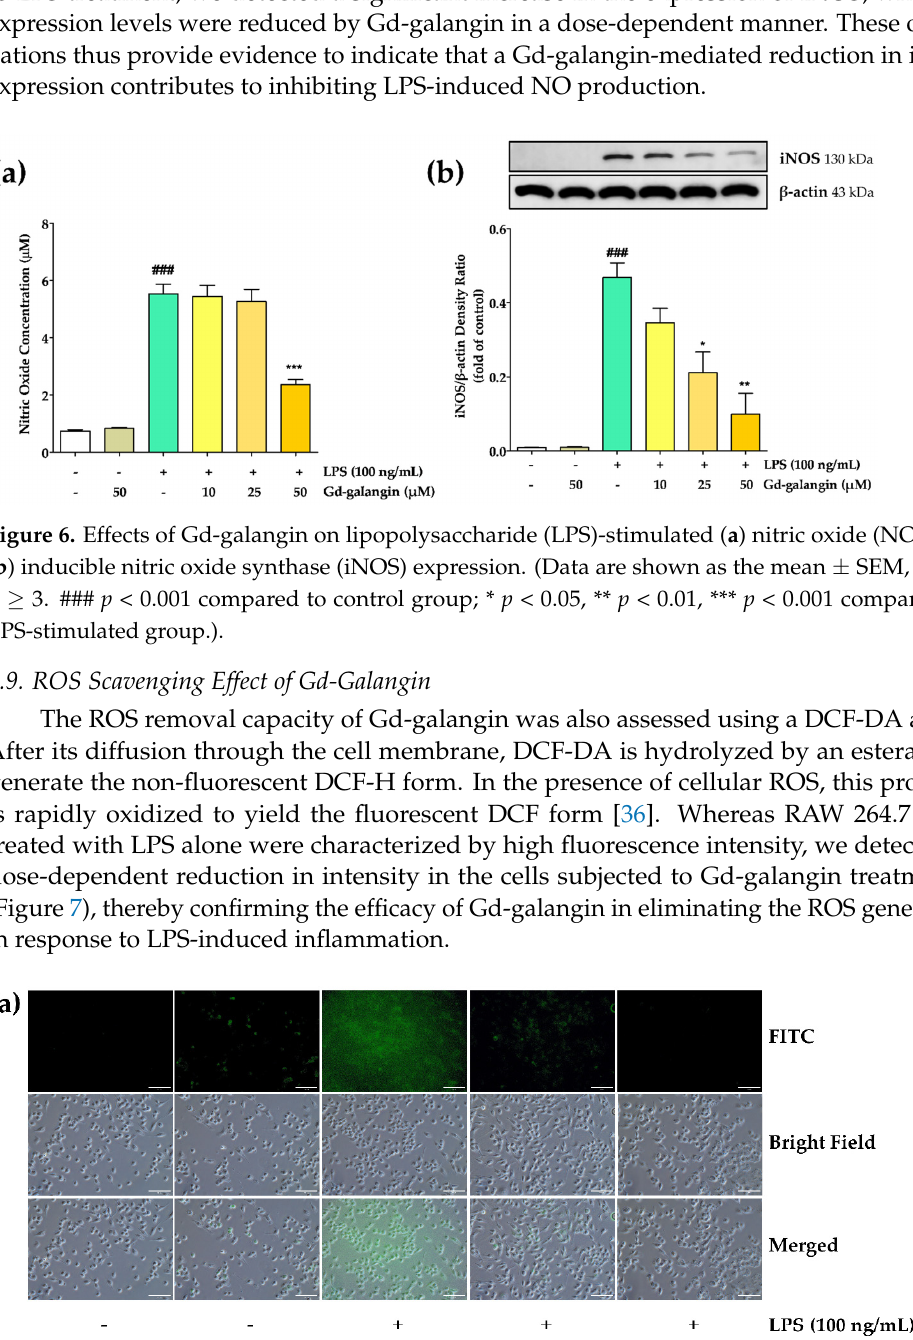
Figure 7. Reactive oxygen species (ROS)-scavenging effect of Gd-galangin on RAW 264.7 macro- phage cells. Cellular ROS was determined by 2,7-dichlorofluoroscin diacetate (DCFDA) assay. ( a ) Images of RAW 264.7 cells captured with fluorescence microscope. Scale bar, 100 μ m. ( b ) The fluo- rescence intensity of ( a ) cellular images. ( c ) The fluorescence intensity measured using a microplate reader. (Data are shown as the mean ± SEM, t -test, n ≥ 3. # p < 0.05, ### p < 0.001 compared to control group; ** p < 0.01, *** p < 0.001 compared to LPS-stimulated group.). 3.10. Anti-Inflammatory Effect of Gd-galangin To assess the inhibitory capacity of Gd-galangin with respect to NLRP3 inflam- masome activation, we examined its ability to downregulate the expression of ASC, IL- 1 β , and NLRP3. On the treatment of RAW 264.7 cells with LPS alone, we detected in- creases in the expression of NLRP3 and ASC, which in turn can contribute to the promo- tion of NLRP3 inflammasome activation. The administration of Gd-galangin was ob- served to promote a slight downregulation of the NLRP3 expression induced by LPS (Fig- ure 8a), whereas the elevated levels of ASC and IL-1 β produced in response to LPS treat- ment were dose-dependently downregulated by Gd-galangin (Figure 8b,c). These find- ings thus indicate that Gd-galangin can inhibit the expression of NLRP3 and ASC and their pro-inflammatory product IL-1 β , which by suppressing subsequent NLRP3 inflam- masome activation that believed to have an anti-inflammatory effect.